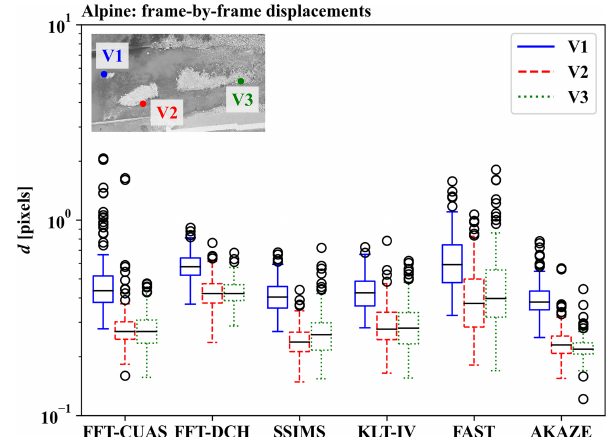
Figure 12. Displacements of validation points relative to their posi- tions in the previous frame for the Kolubara river case study.